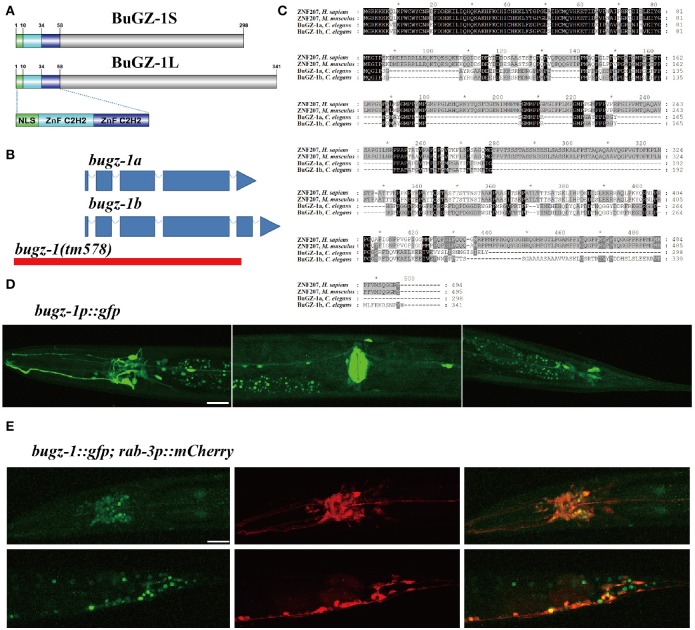
BuGZ-1 is an evolutionary conserved protein with a predicted function as transcription factor and is mainly expressed in the nervous system. (A) Schematic diagram of protein domain structure of two isoforms of BuGZ-1. Both short isoform BuGZ-1S and long isoform BuGZ-1L have a nuclear localization signal (NLS) motif and two zinc finger C2H2 (ZnF C2H2) domains. (B) Schematic diagram of gene structure for bugz-1a and bugz-1b. Blue boxes indicate exons; blue lines indicate introns. 8X backcross of bugz-1(tm578) to wild type was performed before doing experiments. (C) Multiple sequence alignment of the highly conserved N-terminal of BuGZ-1 from different species, including humans (H. sapiens), mouse (M. musculus), and worm (C. elegans). Perfect sequence conservation is indicated in black. (D) Transcriptional expression pattern of bugz-1p::gfp. bugz-1 is expressed in the nervous system, intestine and muscles. Images were taken from head, valve, and tail in ventral view, head to the left. (E) Translational expression pattern of bugz-1::gfp. Neurons are marked with rab-3p::mCherry. Images were taken from head and tail in lateral view, head to the left. BuGZ-1 is mainly localized to the nuclei of neurons. Scale bars indicate 20 μm.